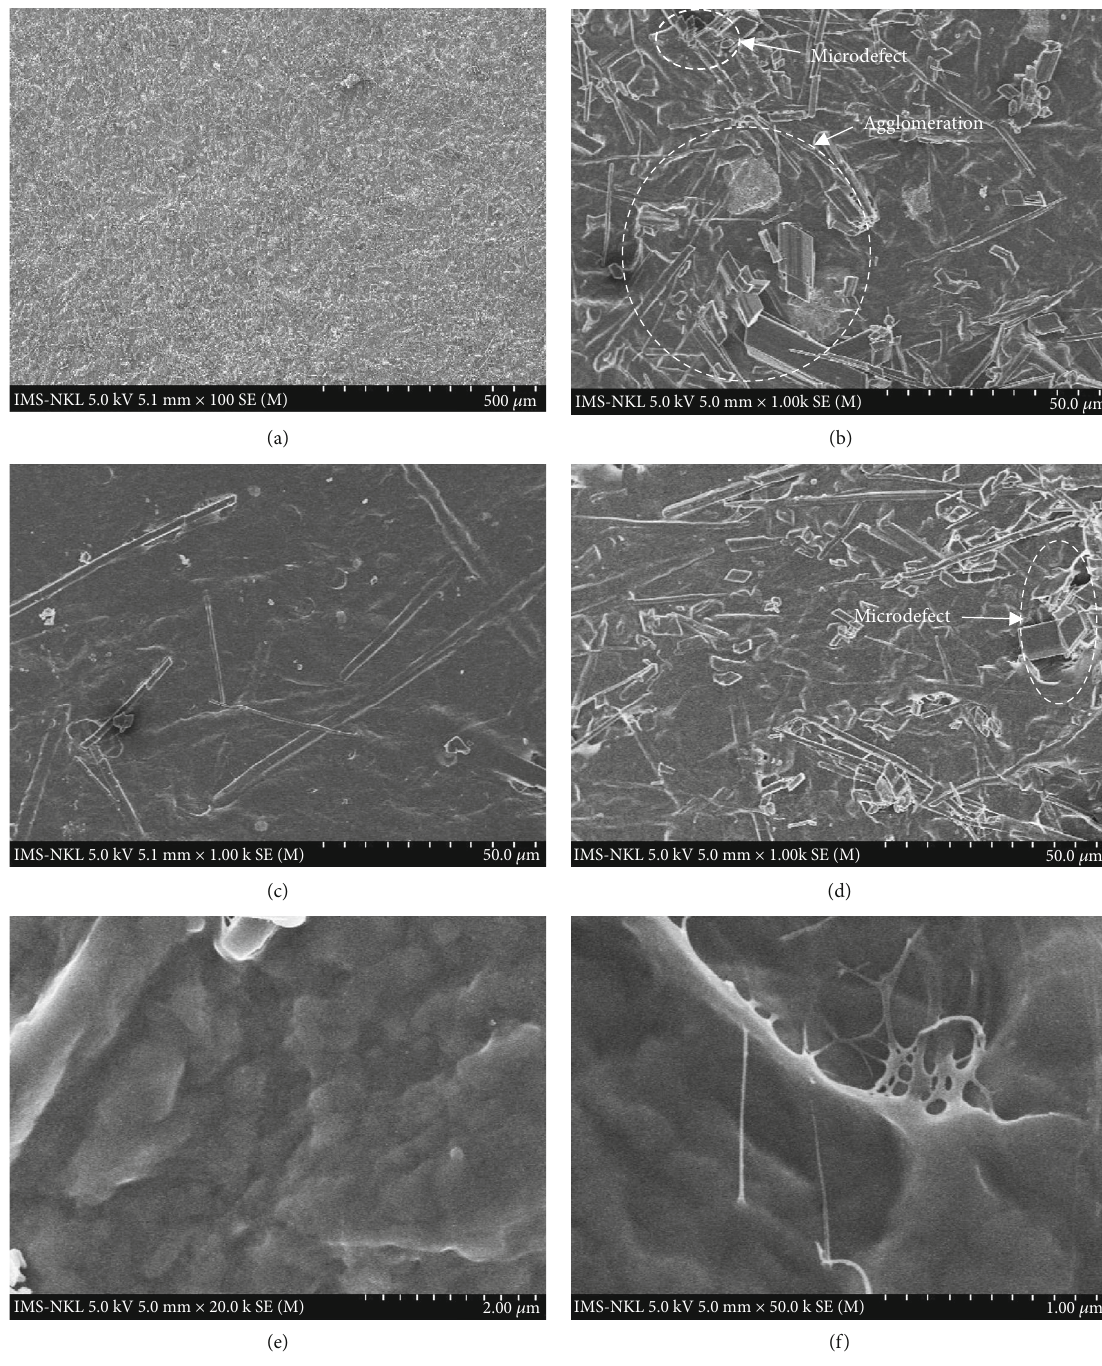
Figure 3: FESEM images of CCA biocomposite fi lms: CCA15 (a, b), CCA5 (c), and CCA10 (d –